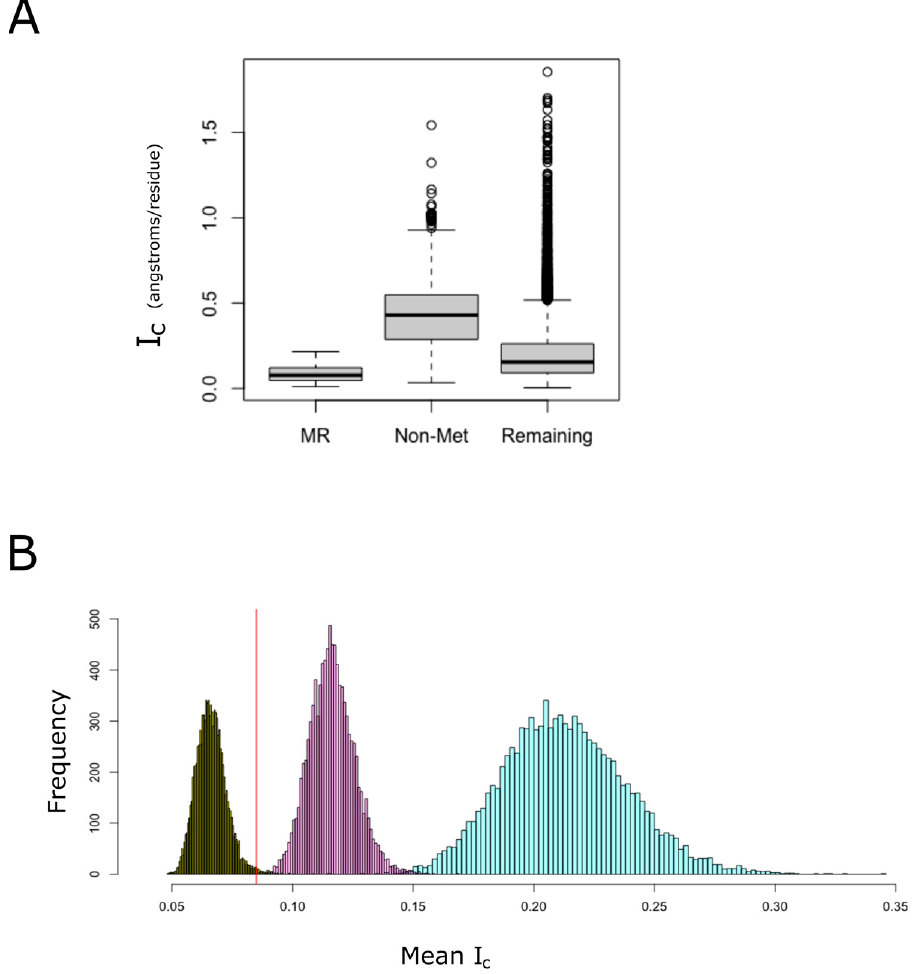
Figure 6. MR-PrLD-containing proteins are more compact than most proteins. Among non-membrane proteins, we distinguished three categories: (i) proteins belonging to the MR-PrLD set (de-noted as MR in the figure), (ii) proteins lacking methionine, other than the one for initiation, in their sequences (denoted as Non-Met in the figure), and (iii) the remaining proteins. For each of these categories, the index of compactness, I c , is plotted using boxplots ( A ). In ( B ), the empirical null distributions of I c mean for 49 proteins randomly sampled from the non-membrane human proteome are shown. Random sampling was carried out in three different ways: (i) without restriction (turquoise color), (ii) matching the protein size with that of the MR-PrLD group (purple color), and (iii) matching the methionine content (dark green color). The computed I c mean value for the MR-PrLD set was 0.085 angstrom per residue, and it is indicated by a vertical red line in the plot.